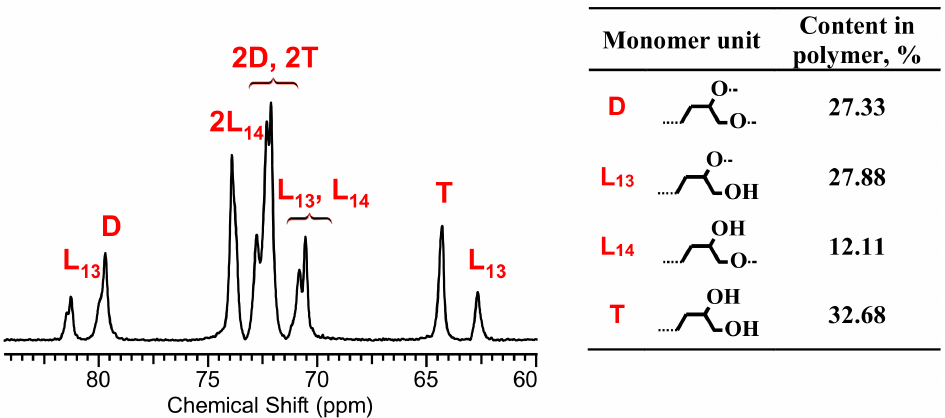
Figure 2. 13 C NMR inverse gated spectrum of polyglycerol and content of different units in the polymer. Carbons belonging to the dendritic, linear 1,3, linear 1,4 and terminal, units are indicated by D, L 13 , L 14 , and T,